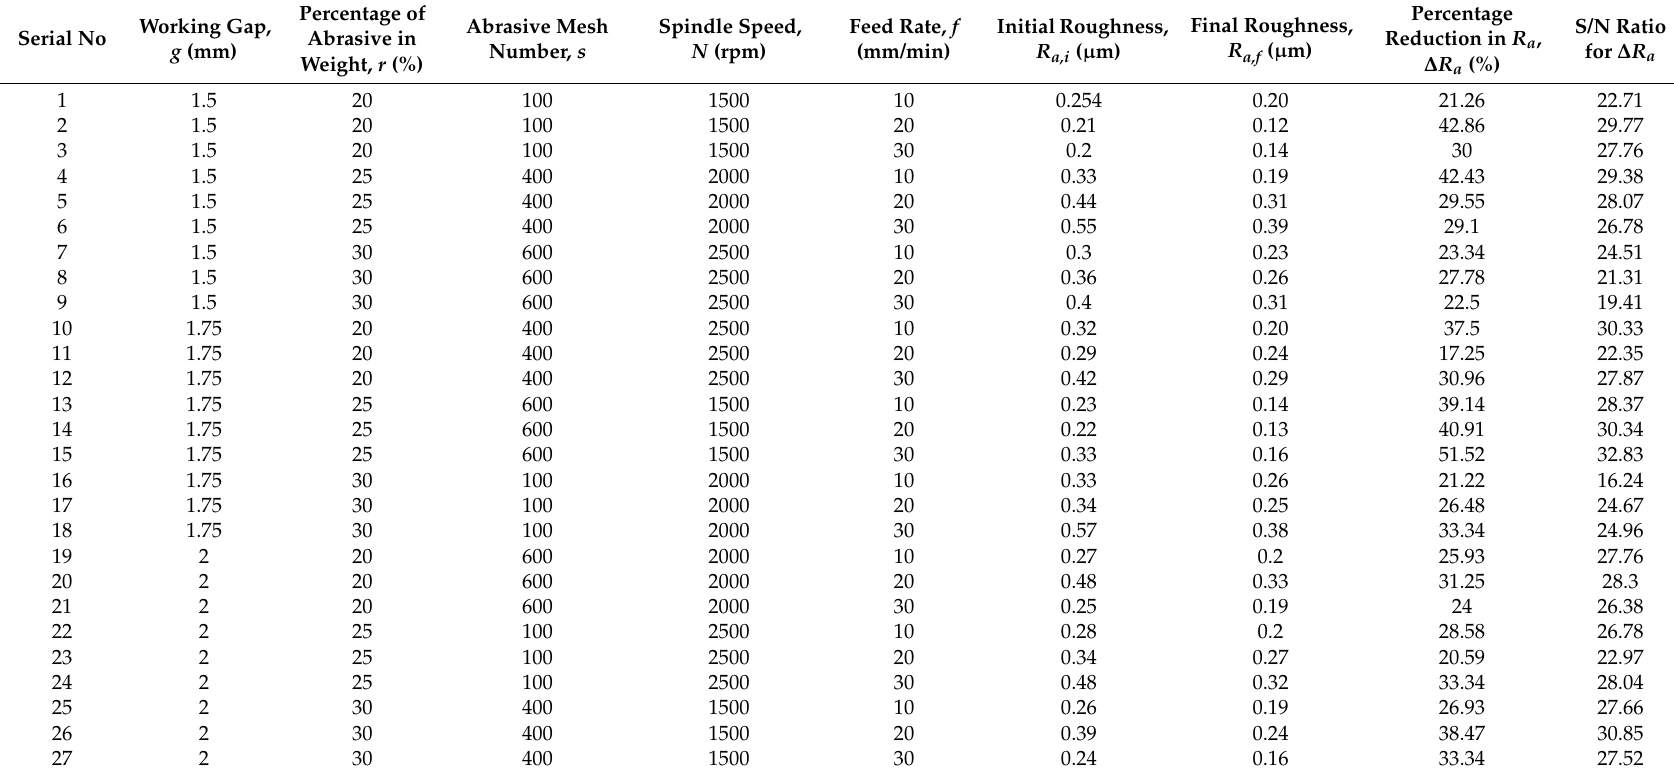
Table 3. Roughness results and estimated signal-to-noise (S/N) ratios of ∆ R a (%) for MAF with SiC